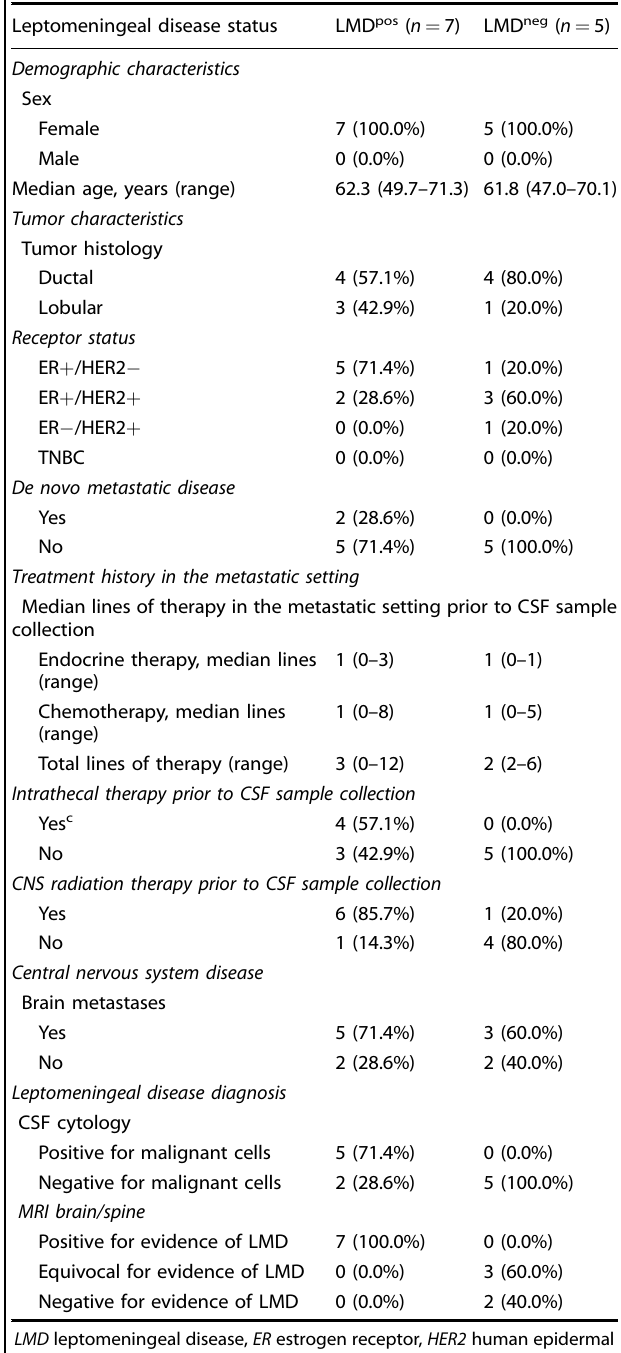
Table 1. Patient demographics and treatment history. Leptomeningeal disease